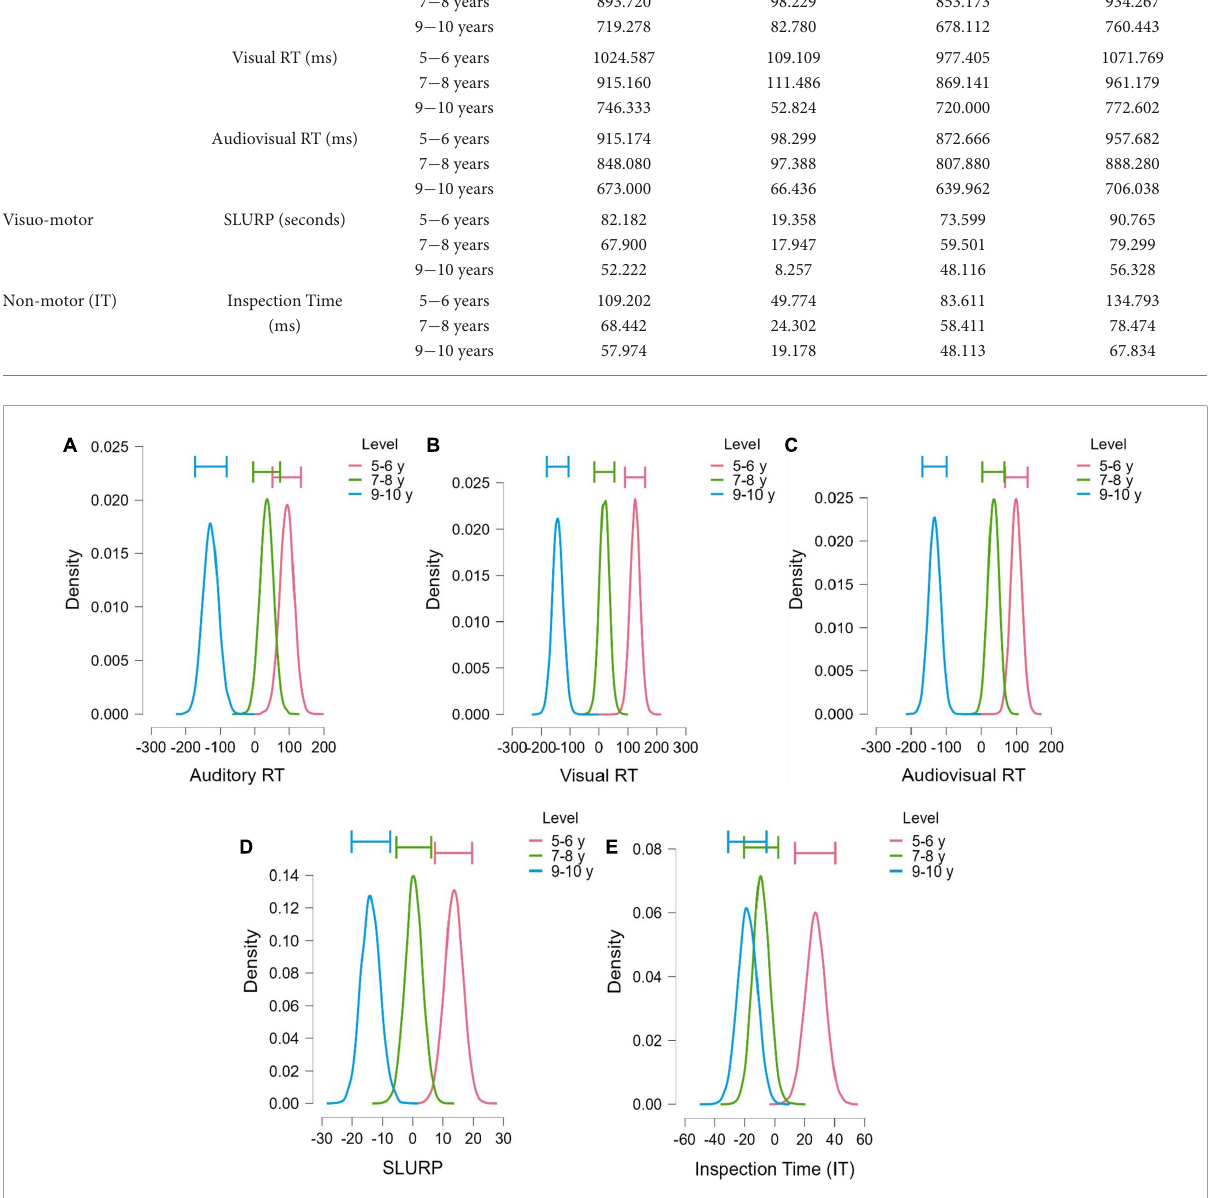
FIGURE5 The model-averaged posterior distribution (horizontal bars show the 95% credible intervals around the median) in MRTs across three conditions (A) auditory (AS), (B) visual (VS) and (C) audiovisual (AVS), (D) visuomotor processing (SLURP), and (E) visual perceptual processing (IT).